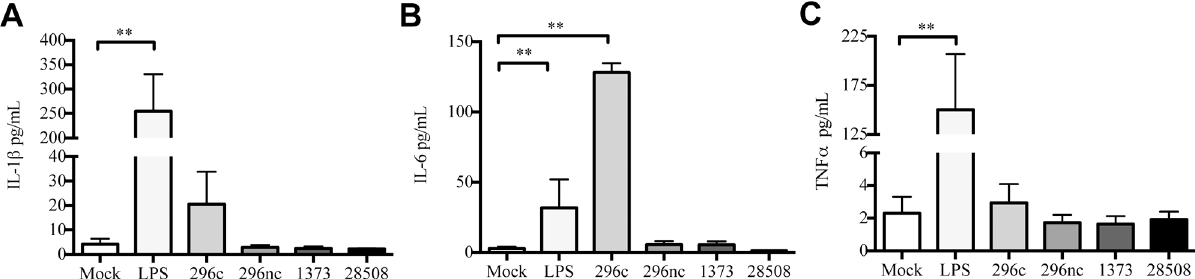
Fig 3. Proinflammatory cytokine secretion of BVDV2 inoculated or LPS stimulated MDM Φ s 24 h after treatment. MDM Φ s were differentiated in 96 well plates for 7 days and inoculated with BVDV2 strains in duplicate at an MOI of 1 or 2 μ g/mL LPS with cell supernatants harvested at 24 h after treatment. Cytokine protein was analyzed by Searchlight Array using analytes specific for bovine IL-1 β (A), IL-6 (B) and TNF α (C) with 50 μ L of cell supernatant analyzed in duplicate. Cytokines were quantified by generation of standard curves against recombinant bovine cytokines provided by the manufacturer of the Searchlight platform. Bars represent the mean value ± SEM from four different experiments from 9 total donor cattle. ** P < 0.001.